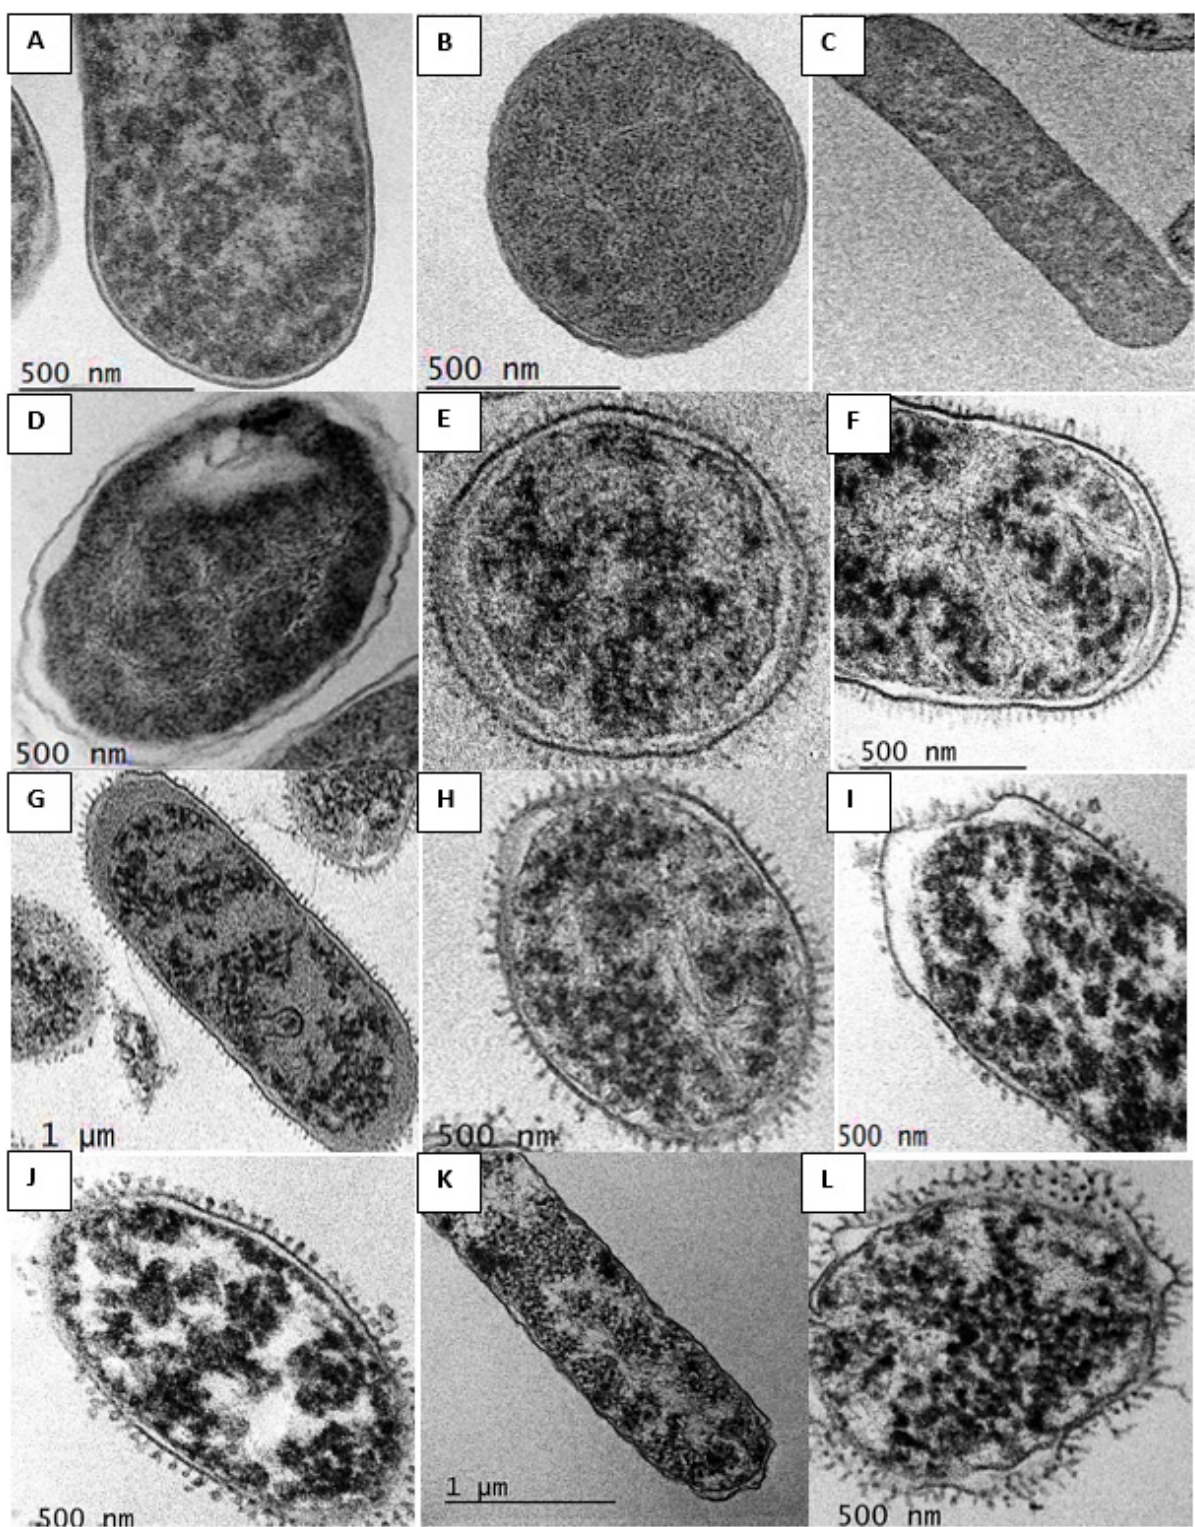
Figure 3. TEM micrographs of Escherichia coli 184 cells treated with ( A – C ) control; ( D ) Alg NPs (500 µg/mL); ( E – F ) Colistin (8 µg/mL); ( G – H ) Alg NPs+Colistin (500:1.25) µg/mL; ( I – J ) Alg NPs+Col- istin+Lactic acid (500:0.62:15) µg/mL; ( K – L ) Alg NPs+Colistin+Menthol (500:0.31:10) µg/mL.